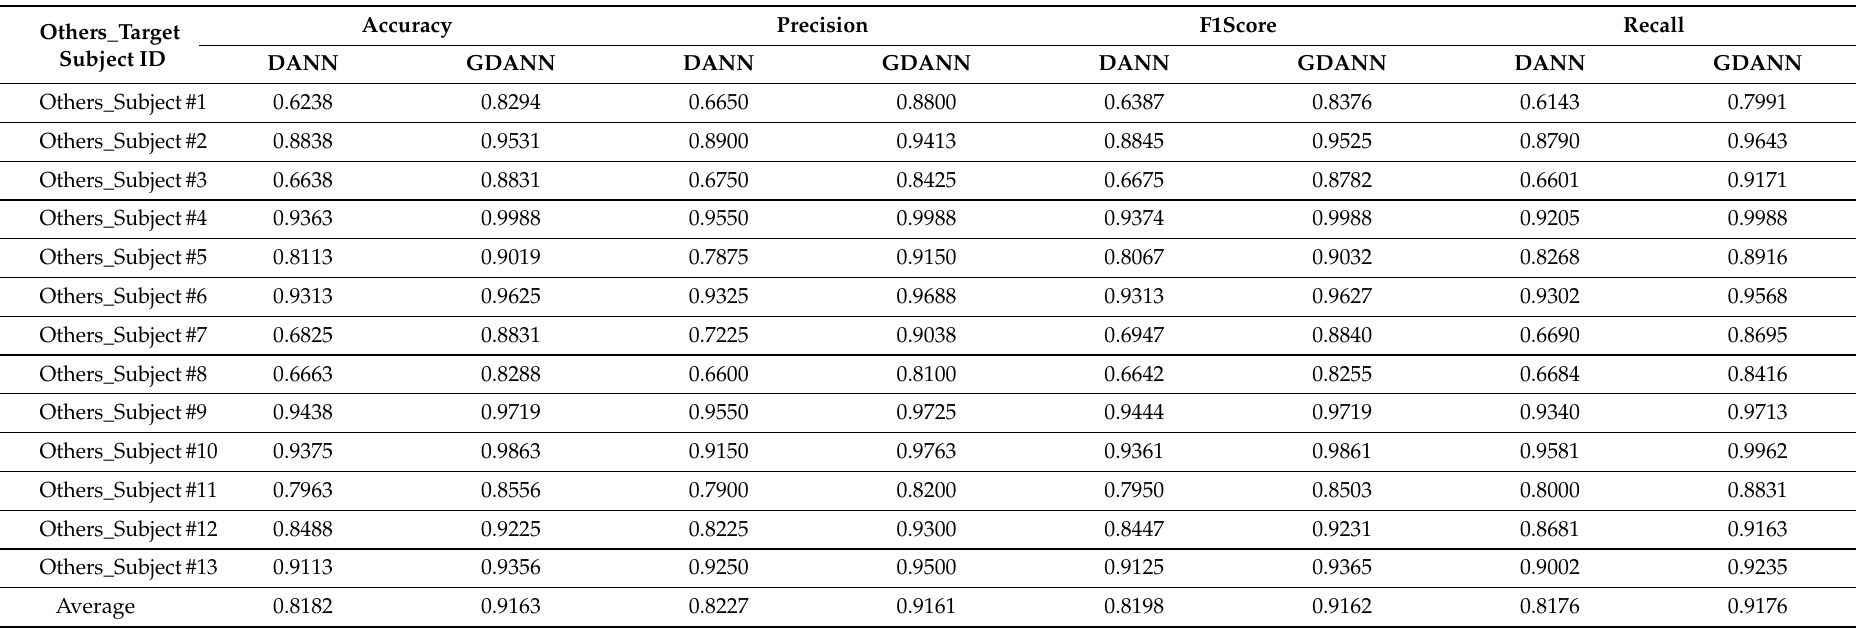
Table 2. Comparison results of the confusion matrix indicators between DANN and